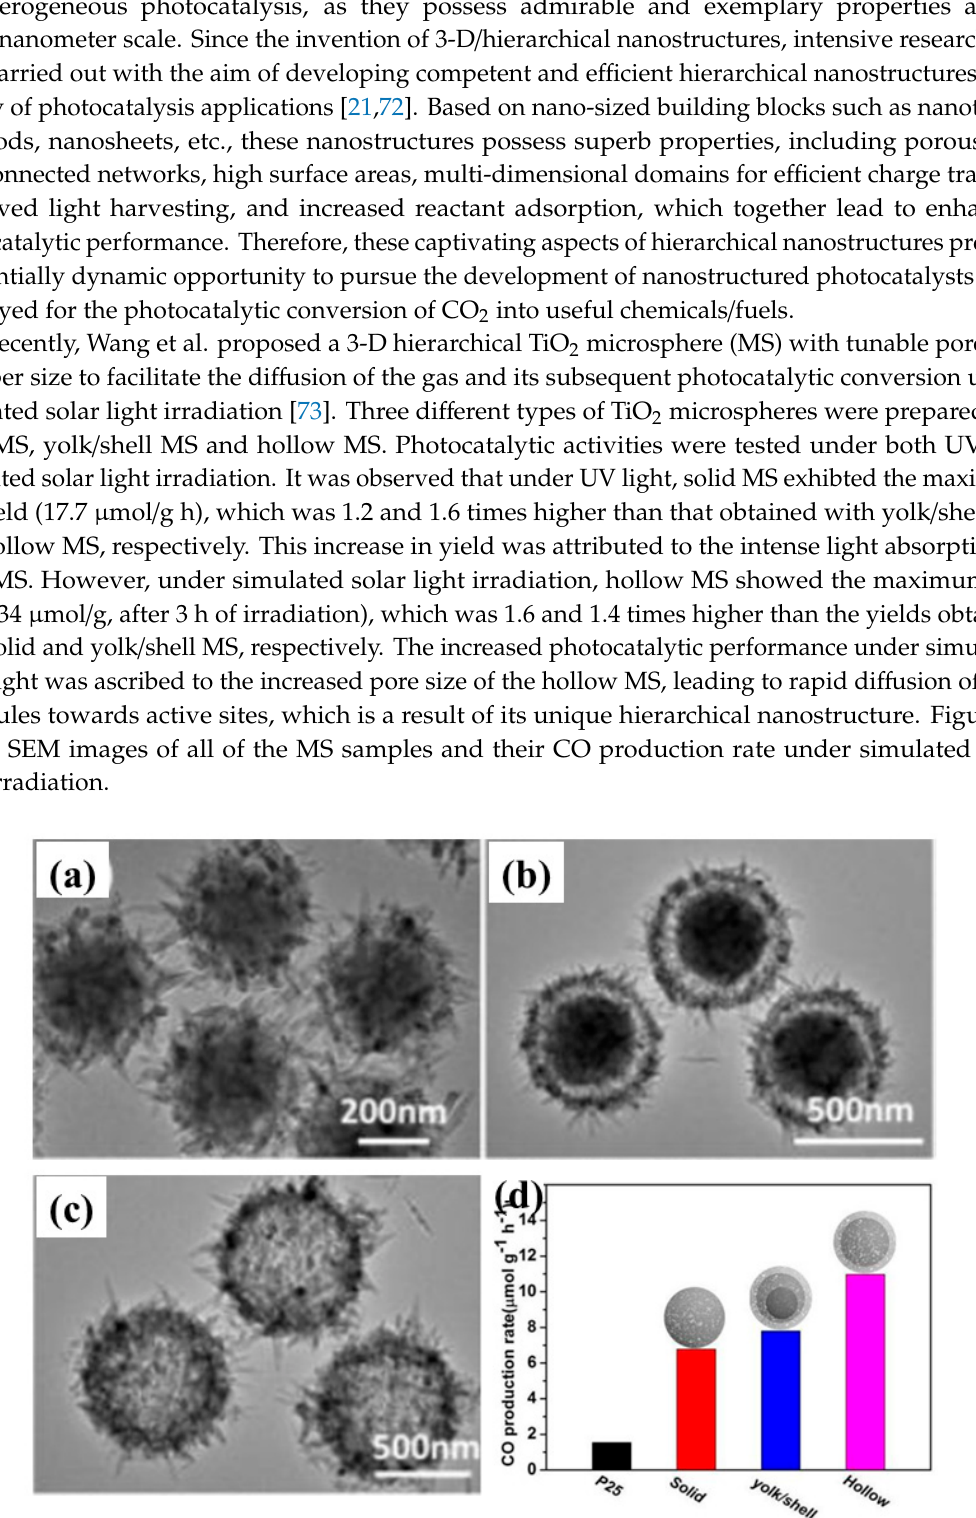
Figure 11. SEM images of ( a ) solid MS, ( b ) yolk / shell MS, and ( c ) hollow MS. ( d ) CO production rate for various samples via photocatalytic CO 2 conversion (taken with permission from [73]).